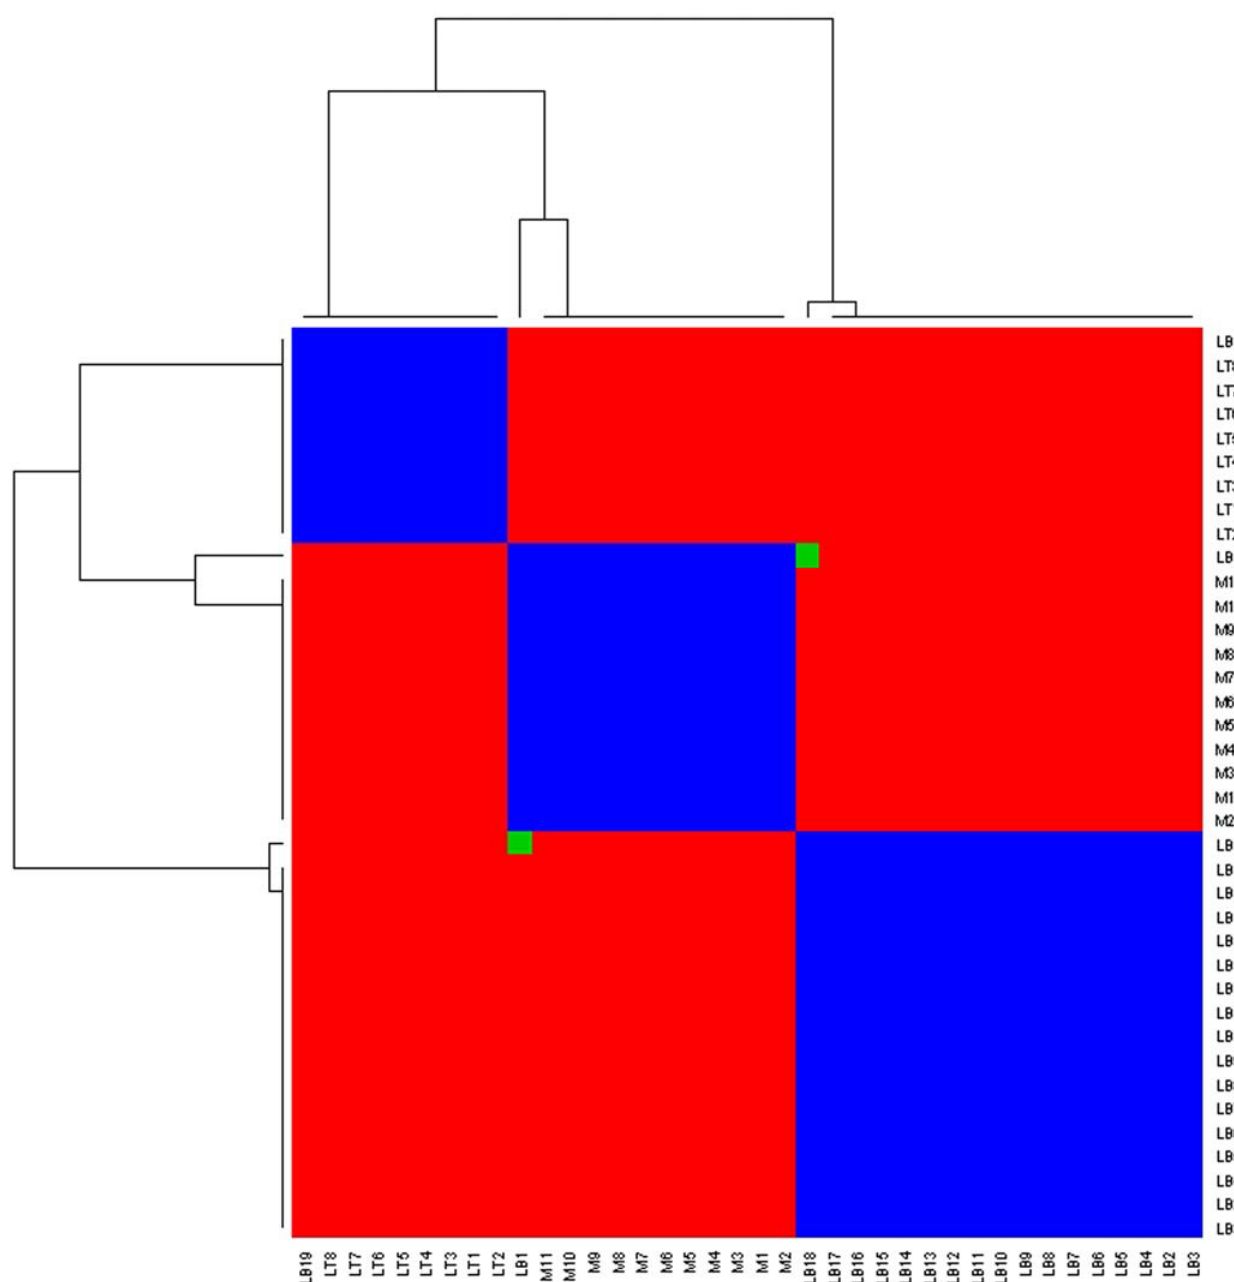
Figure 5. Heat map of re-ordered consensus matrix, k =3.